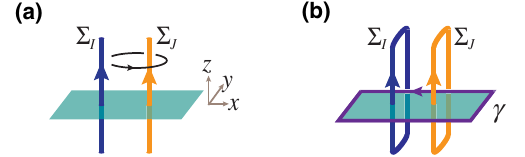
FIG. 14. (a) The configuration of two strings Σ aligned along the z direction and penetrate the z ¼ 0 plane (green region) where Θ jumps by 2 π . The strings Σ nontrivial braiding. (b) The configuration of a finite open surface γ across which Θ jumps by 2 π together with strings Σ are linked with the vortex loop ∂ γ (purple border).